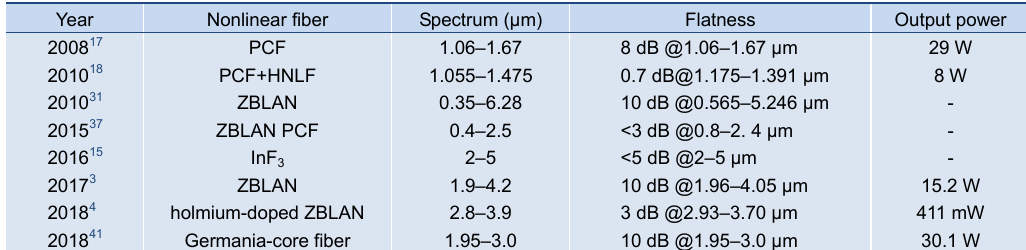
Table 1 | Summary of typical SC works with specialty optical